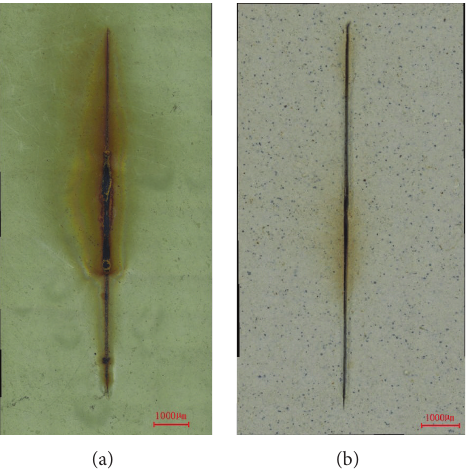
Figure 11: Micrographs of the epoxy antirust painted samples (a) and studied painted samples (b) with defect after immersion